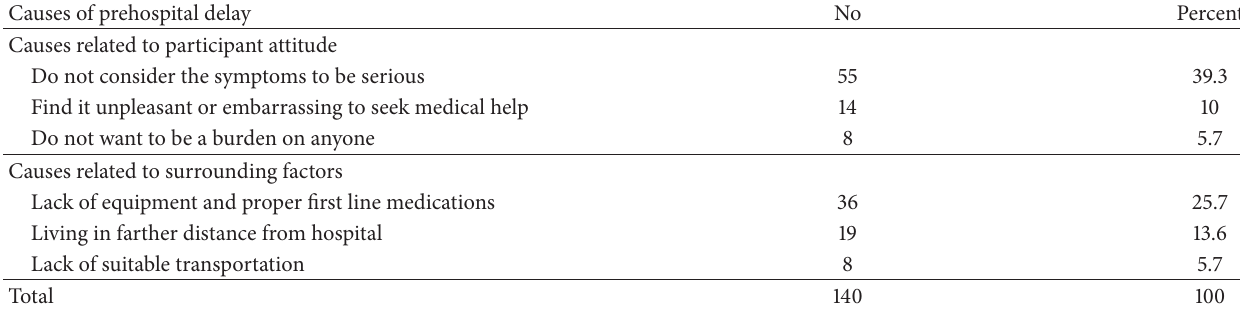
Table 3: Causes of prehospital delay among study participants.